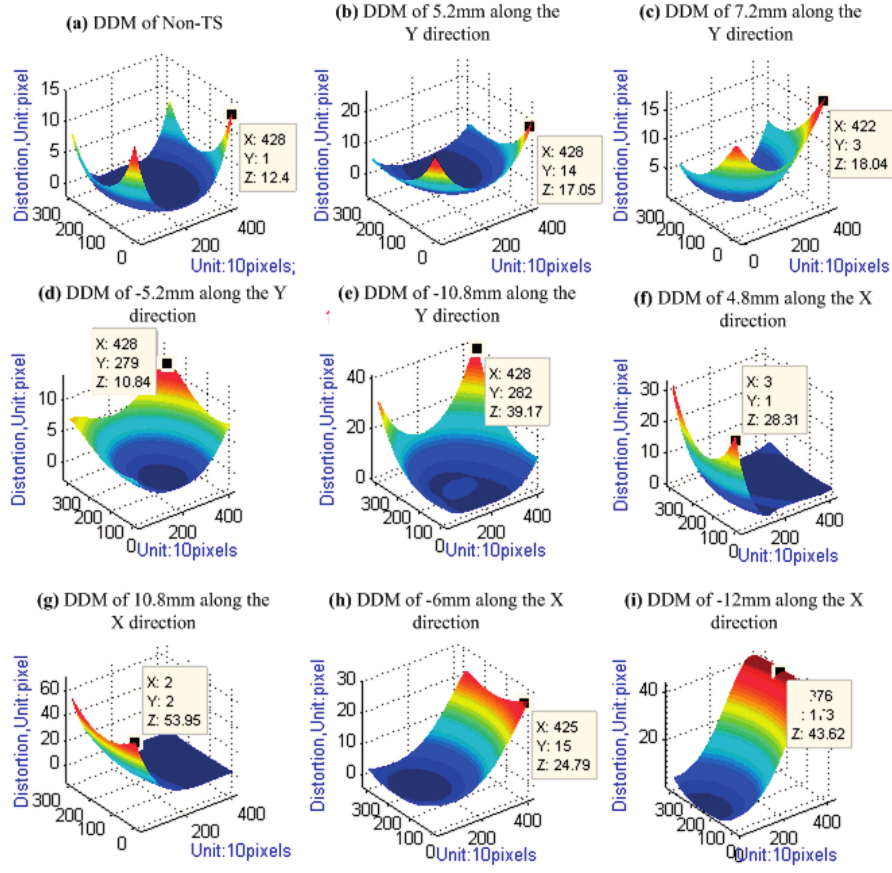
Figure 8. ( a ) Existing angle between the Y-axis and y-axis and ( b ) existing angle between the X-axis and x-axis.